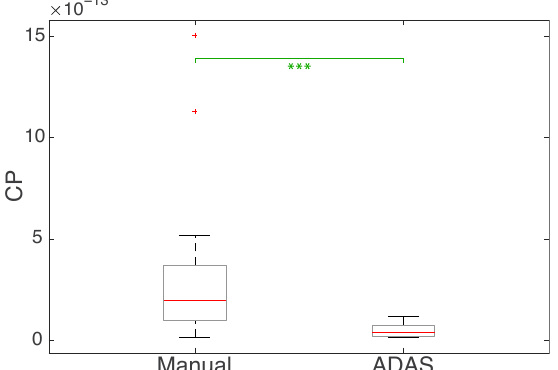
Figure 10. ( a ) Box plot of EBR among subjects in Manual and ADAS scenarios; ( b ) box plot of beta power; ( c ) box plot of SPR RMS; ( d ) box plot of HR. The green asterisks refer to the p -values computed using t -tests.